Question: What does this figure show? Answer in one sentence.
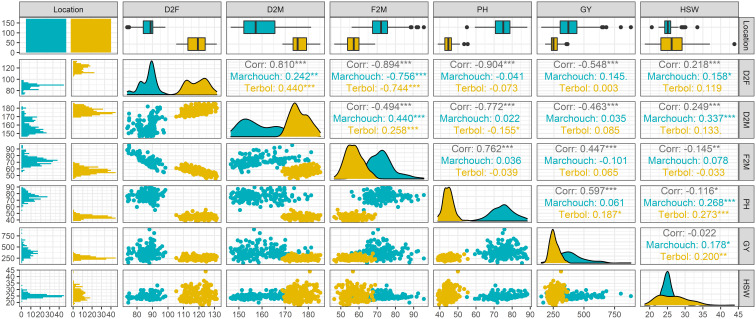
Answer: Pairwise correlations between the agronomic parameters recorded for all chickpea-tested genotypes at Marchouch and Terbol.